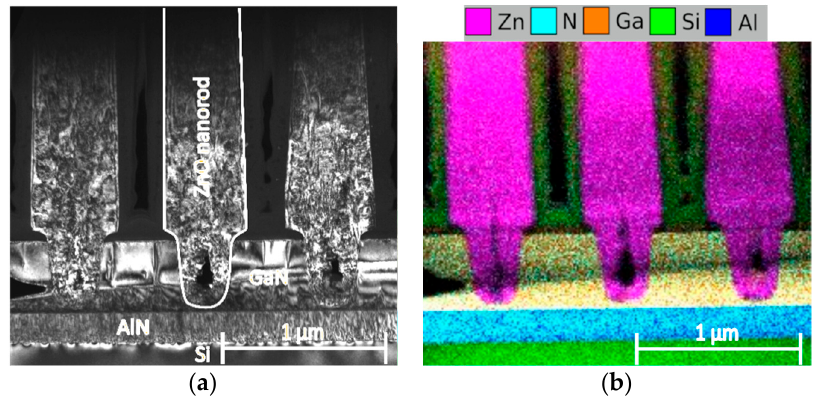
Figure 6 . ( a ) TEM image of the interface between the ZnO nanorod and GaN substrate; ( b ) Energy-dispersive X-ray Spectroscopy analysis (EDX) of the interface between the ZnO nanorods and the GaN substrate.